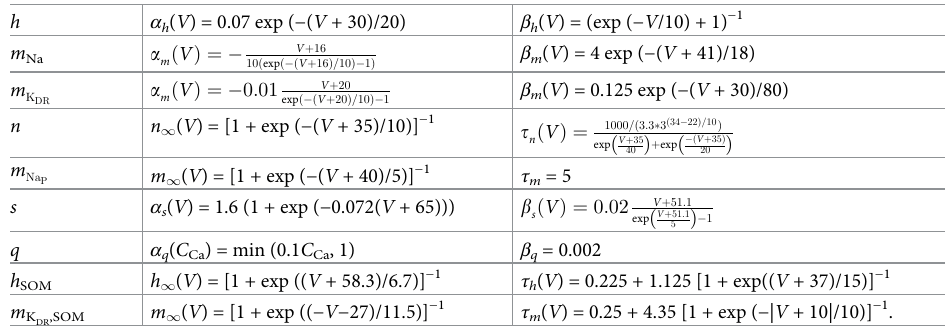
Table 4. Activation variable